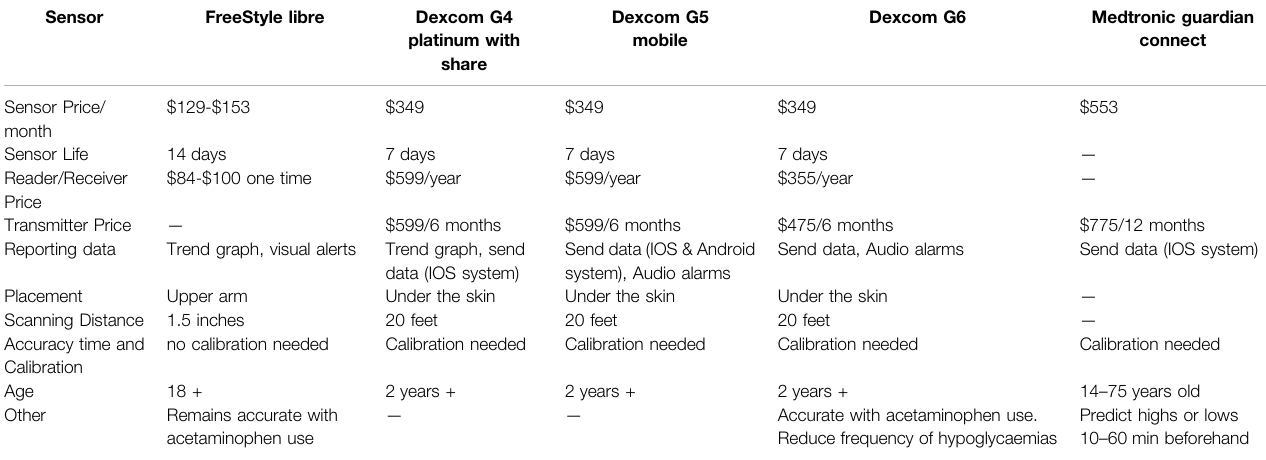
TABLE 3 | Comparative table of fi ve Commercially available